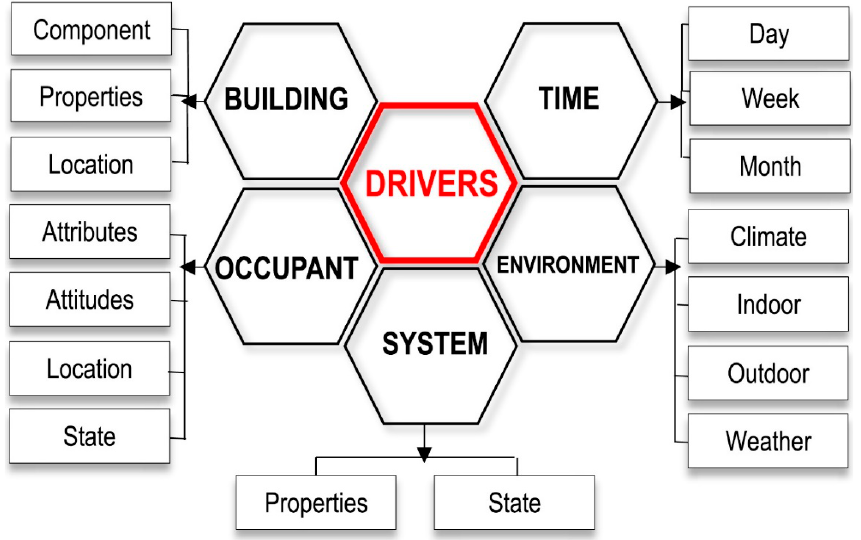
Figure 12. Drivers that impact energy ‐ related occupant behavior [112] (Reprinted from Elsevier Building and Environment, Volume 92, Tianzhen Hong, Simona D’Oca, William J.N. Turner, Sarah C. Taylor ‐ Lange, An ontology to represent energy ‐ related occupant behavior in buildings. Part I: Introduction to the DNAs framework, Pages No. 764–777, Copyright (2015), with permission from Elsevier [OR APPLICABLESOCIETY COPYRIGHT OWNER]).